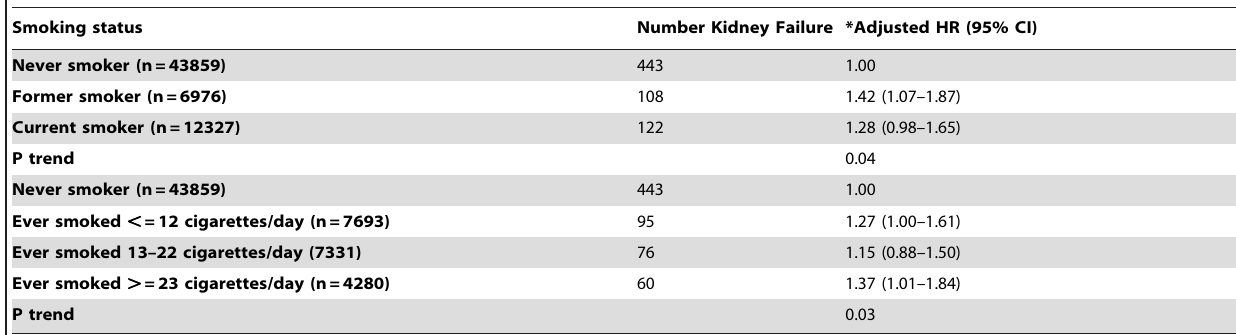
Table 3. Risk of Kidney Failure by Smoking Status in Singapore Chinese Cohort Study.